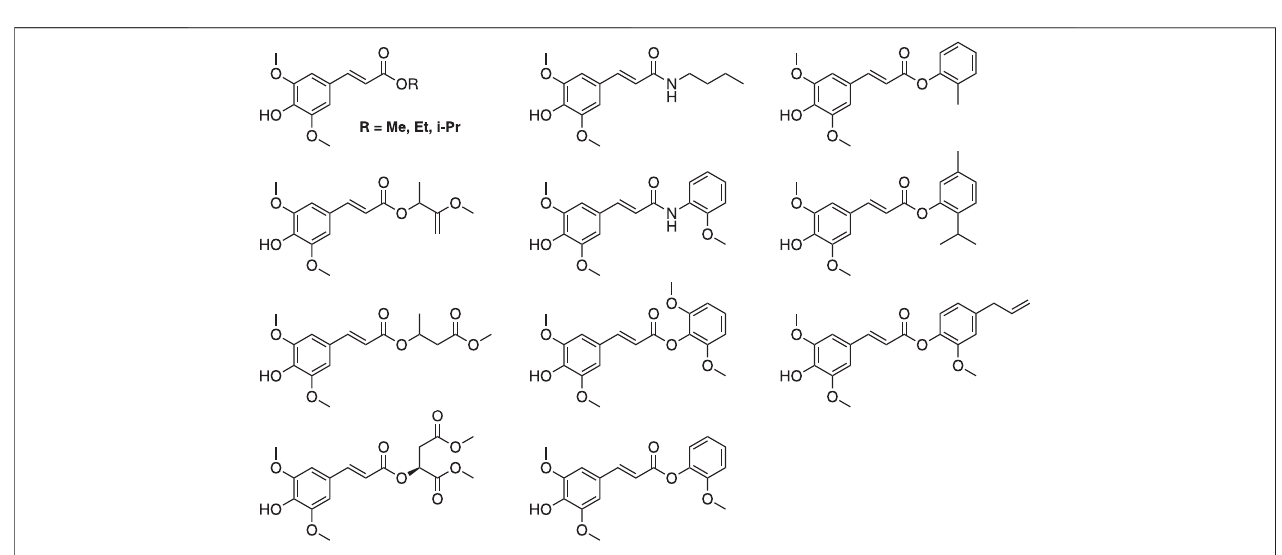
FIGURE 16 | Several structural examples of other sinapate